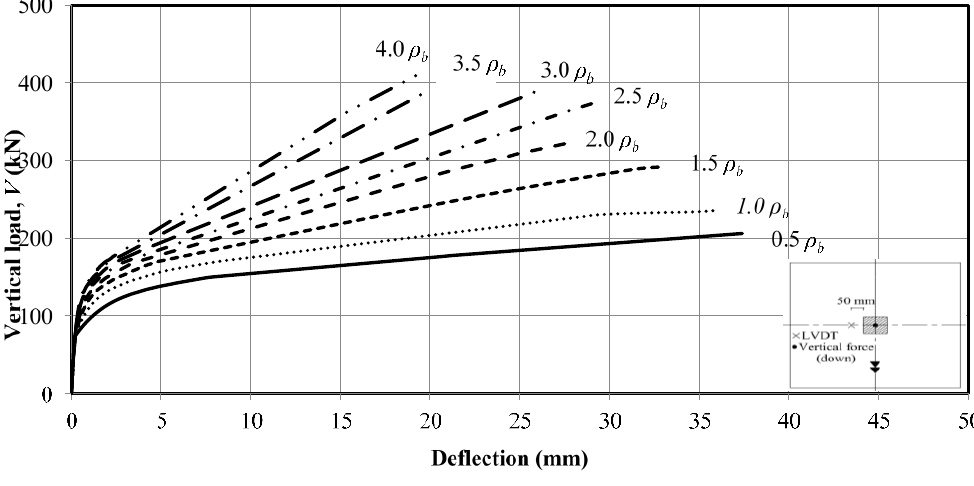
Figure 9. Variation in load-deflection relationship with the reinforcement